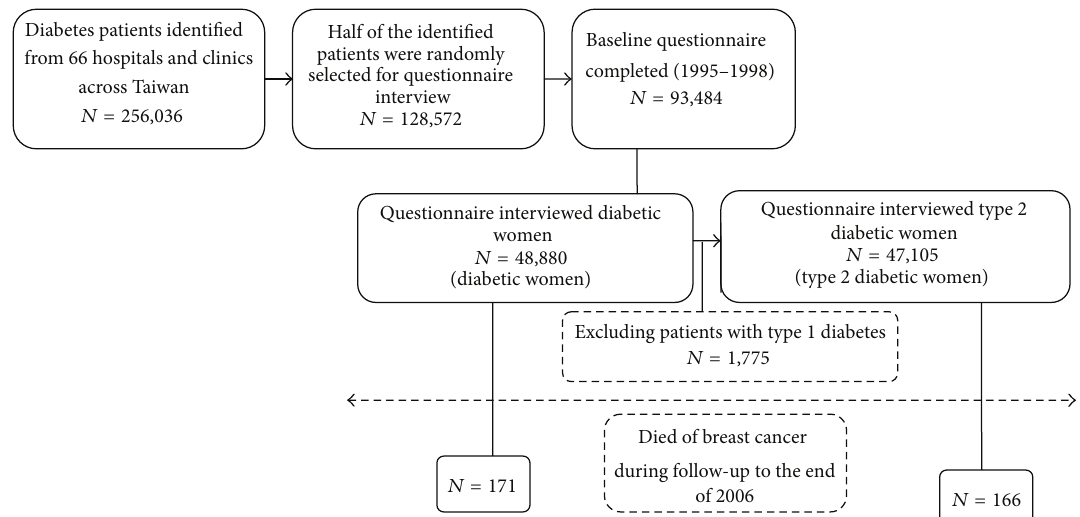
Figure 1: Flow chart showing the procedures for the followup of women with diabetes from a nationally representative cohort for breast cancer